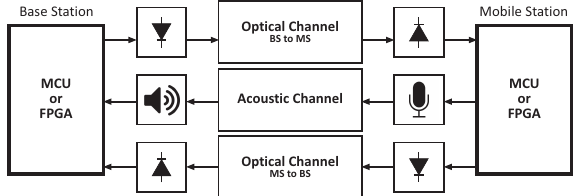
Figure 1. Hybrid Visible Light Communication-ultrasound system for distance estimation. Where MCU is a microcontroller unit and FPGA is a Field Programmable Gate